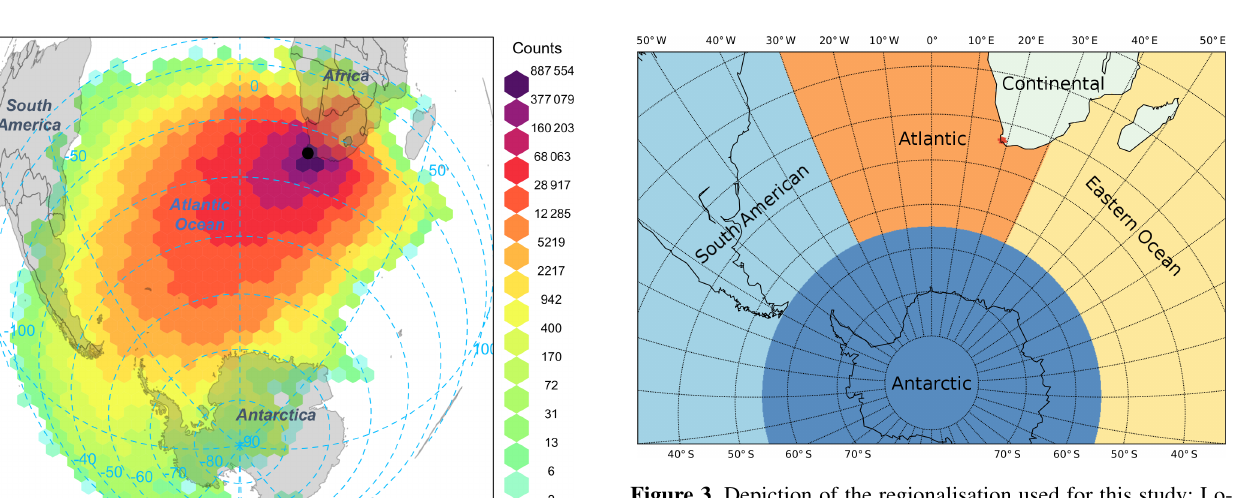
Figure 3. Depiction of the regionalisation used for this study: Lo- cal (red), Continental (light green), Eastern Ocean (yellow), South American (turquoise), Antarctic (blue), and Atlantic